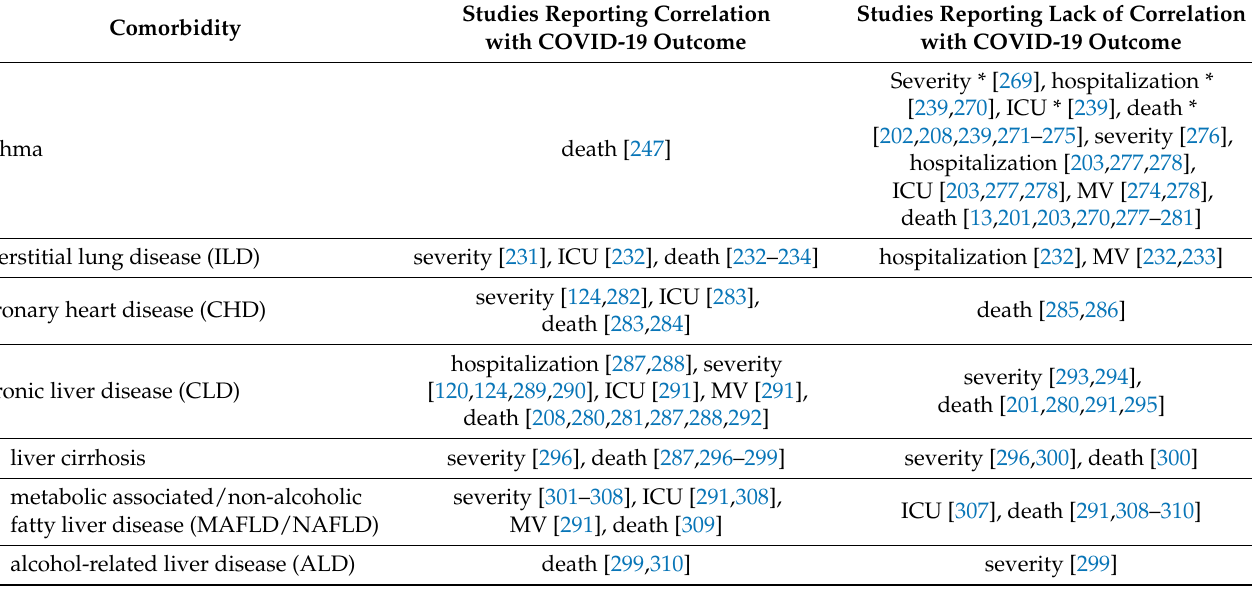
Table 4. Comorbidities with weakly supported or controversial association with COVID-19